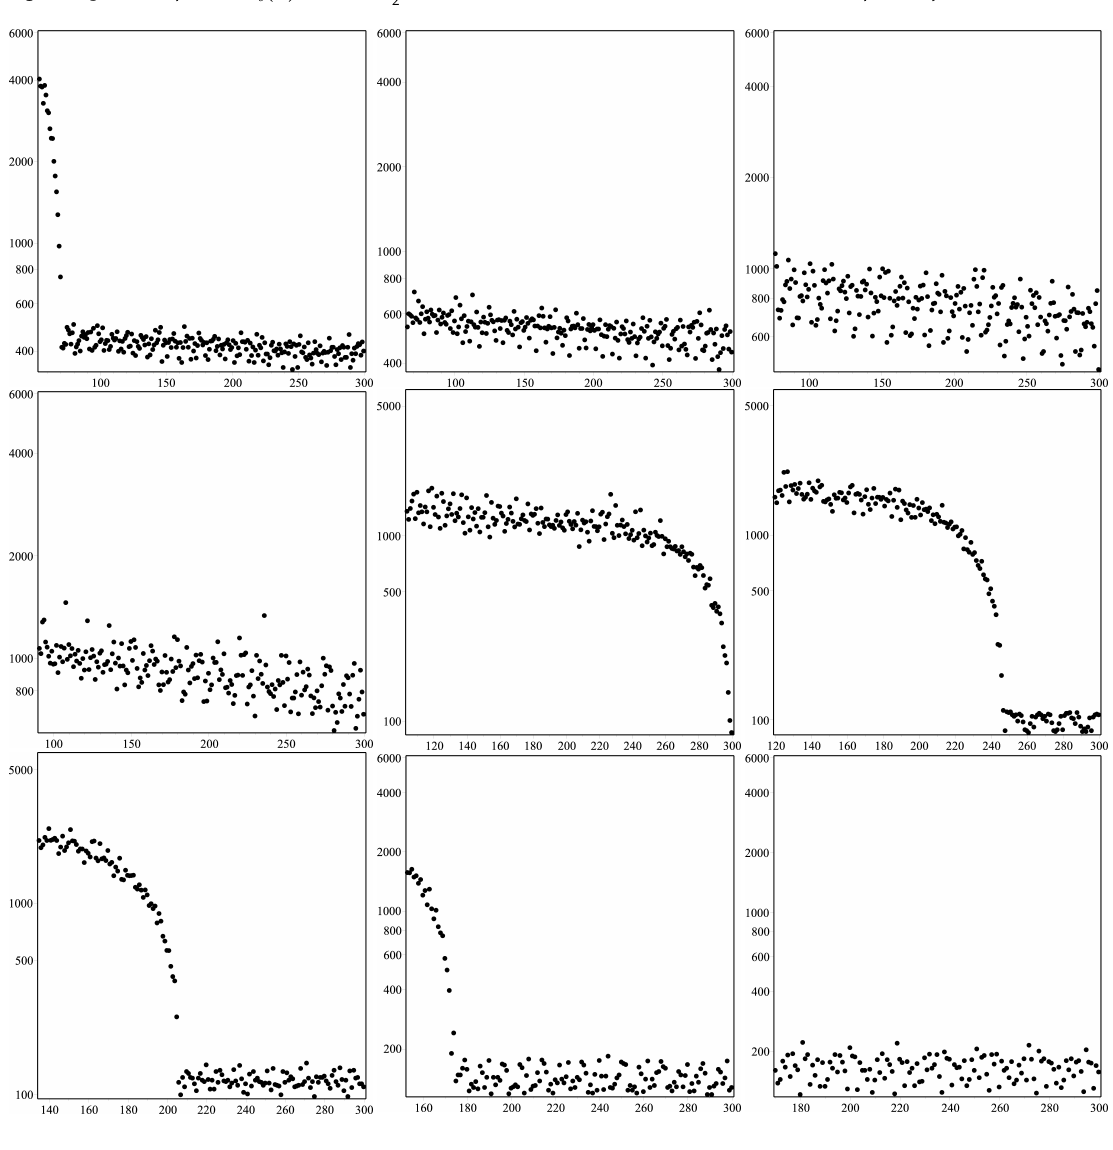
Fig. 6. Logarithmic plots of σ (cid:96) ( d ) for (cid:96) ⋅( (cid:96) − 1 )− 1 +(− 1 )